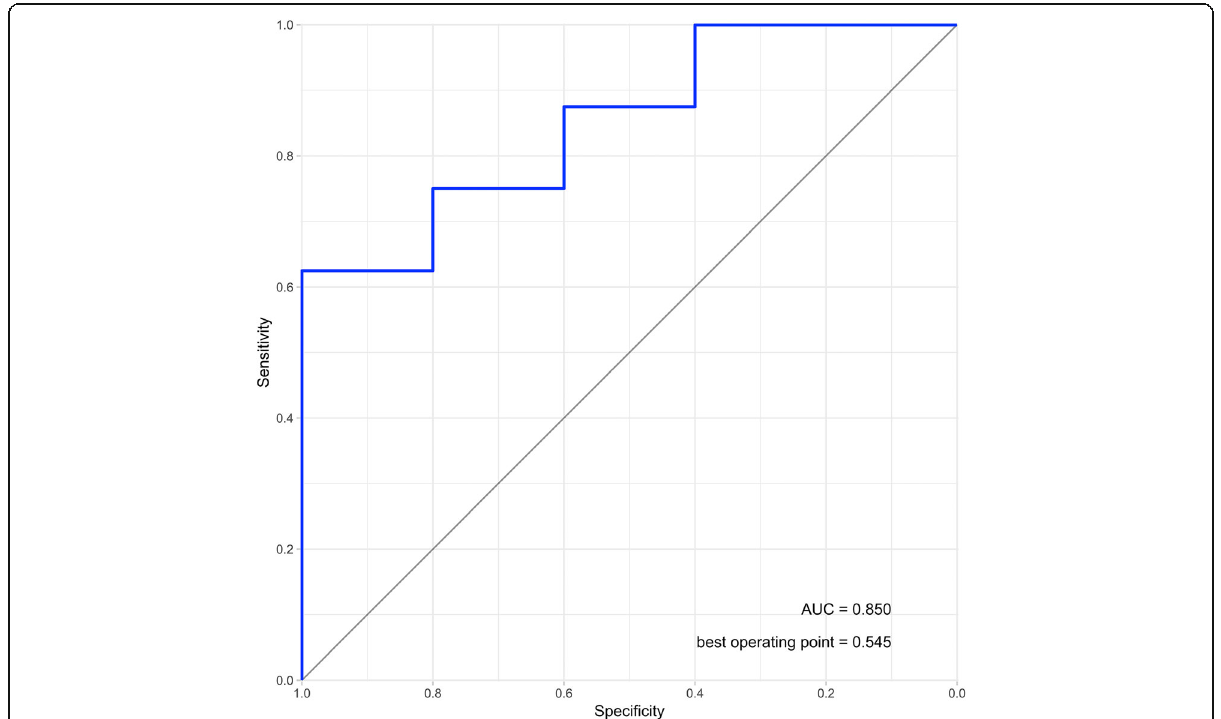
Fig. 5 ROC-analysis for the final validation set of previously unseen